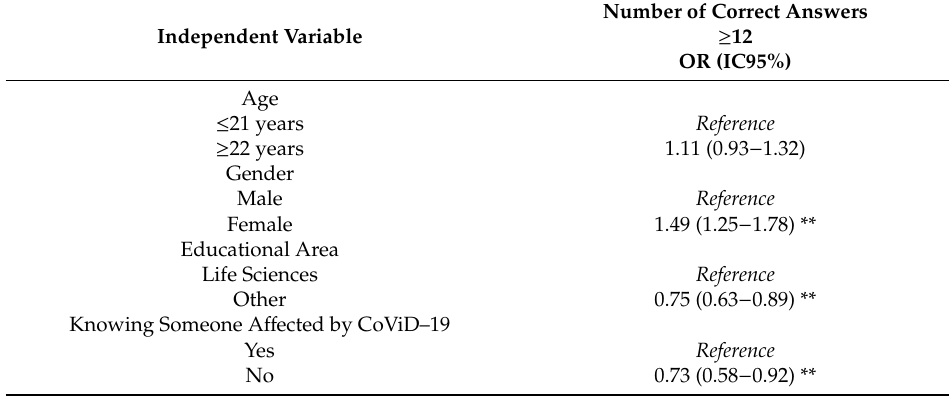
Table 4. Results of the logistic regression model built on the number of correct answers as the outcome. Independent